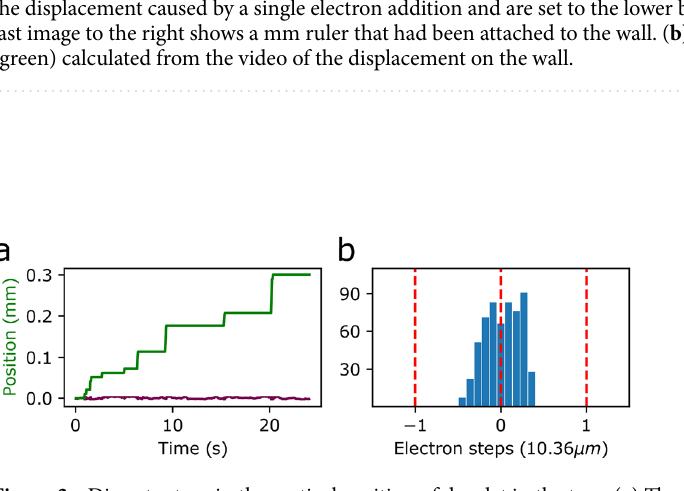
Figure 3. Discrete steps in the vertical position of droplet in the trap. ( a ) The green line shows a fit of the data shown in Fig. 2b using a step function. The height of the steps is an integer multiple of the single electron step fitting parameter (see discussion in text). The magenta line shows a plot of the residue between the data and the fit. ( b ) Histogram of the residue measured in units of electron steps. The normal distribution around zero results from the discrete nature of the